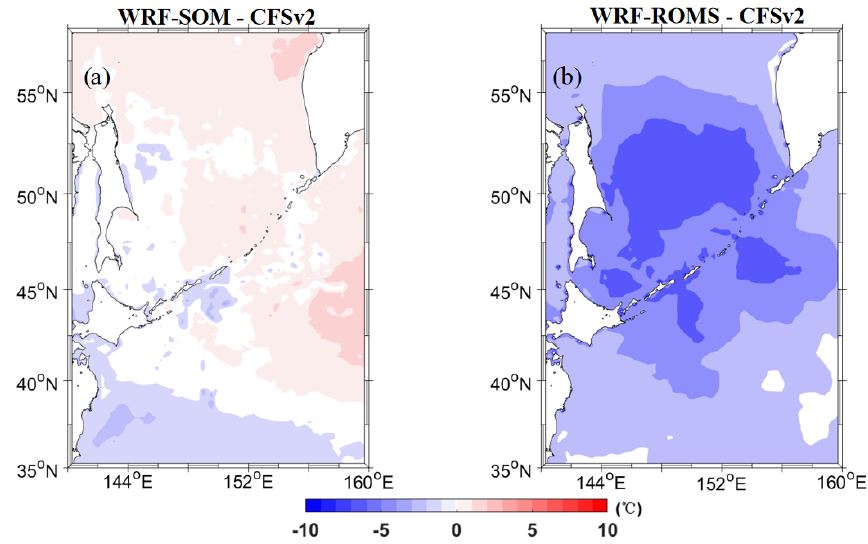
Figure 6. The spatial distribution of air temperature errors in the cold deviation area at the surface in the (a) WRF-SOM, and (b) WRF-ROMS against Climate Forecast System version 2 (CFSv2) reanalysis of total 142 forecast cases from 19 July to 31 December 2020 averaged in the 34d forecast